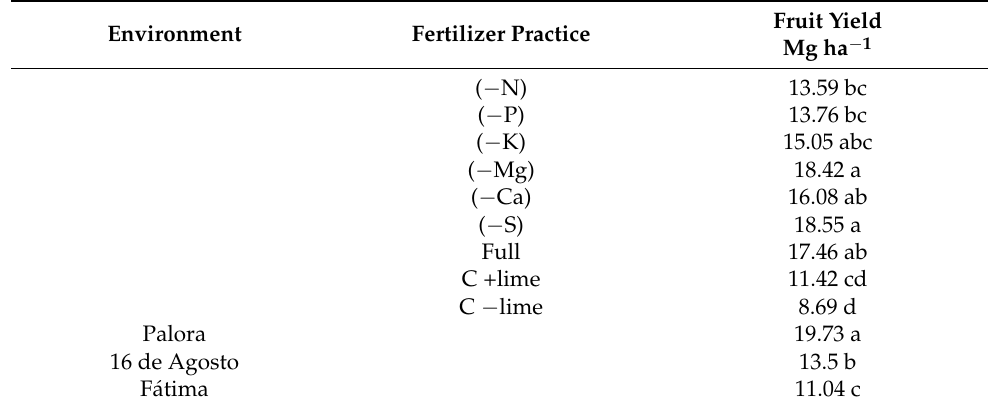
Table 4. Mean values for fruit yield determined for each factor: Environment and fertilizer practice. Mean values are reported. Within a column and within a given factor, means followed by the same letter are not statistically different (alpha = 0.1).